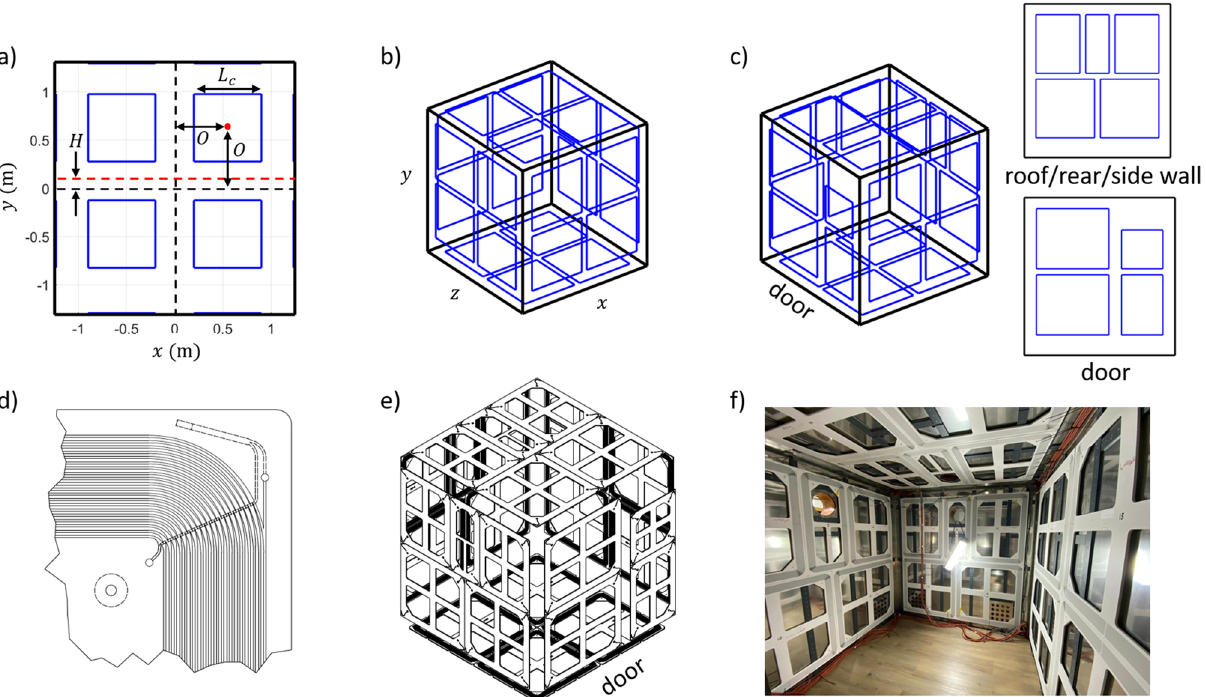
Figure 2. The window coil active magnetic shielding system. ( a ) Parameterisation of the window coil. Four square coils are arranged with four-fold symmetry on each face. The coil square side length, offset from the centre of the window and offset in the vertical axis are shared between all faces. Coil parameters are optimised to produce known components of magnetic field over the central cubic metre of the MSR. ( b ) Final optimised window coil featuring 24 identical square coils. This structure is challenging to engineer due to the need to incorporate the access door and projection ports in 3/6 walls. ( c ) Adapted design accounts for geometry of the MSR and features 27 coils. ( d ) Drawing of the corner of a single coil panel. To accommodate 20 turns of wire in each coil, a series of grooves are arranged in a spiral pattern into which copper wire is placed. The conductor return path is also shown. ( e ) Final model of the window coil featuring all panels. ( f ) Photograph of installed coil panels (floor coils hidden beneath the flooring and door coils hidden by angle of photograph) taken prior to